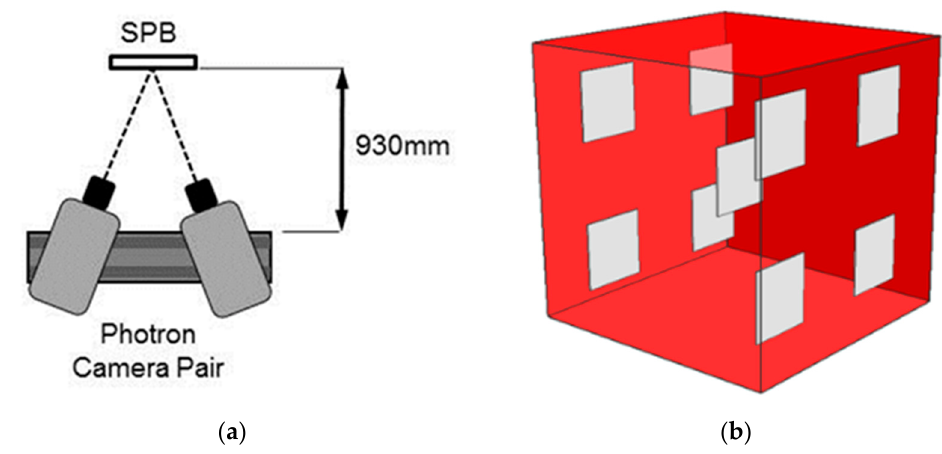
Figure 3. ( a ) Camera set-up and ( b ) measurement locations across the calibrated volume.